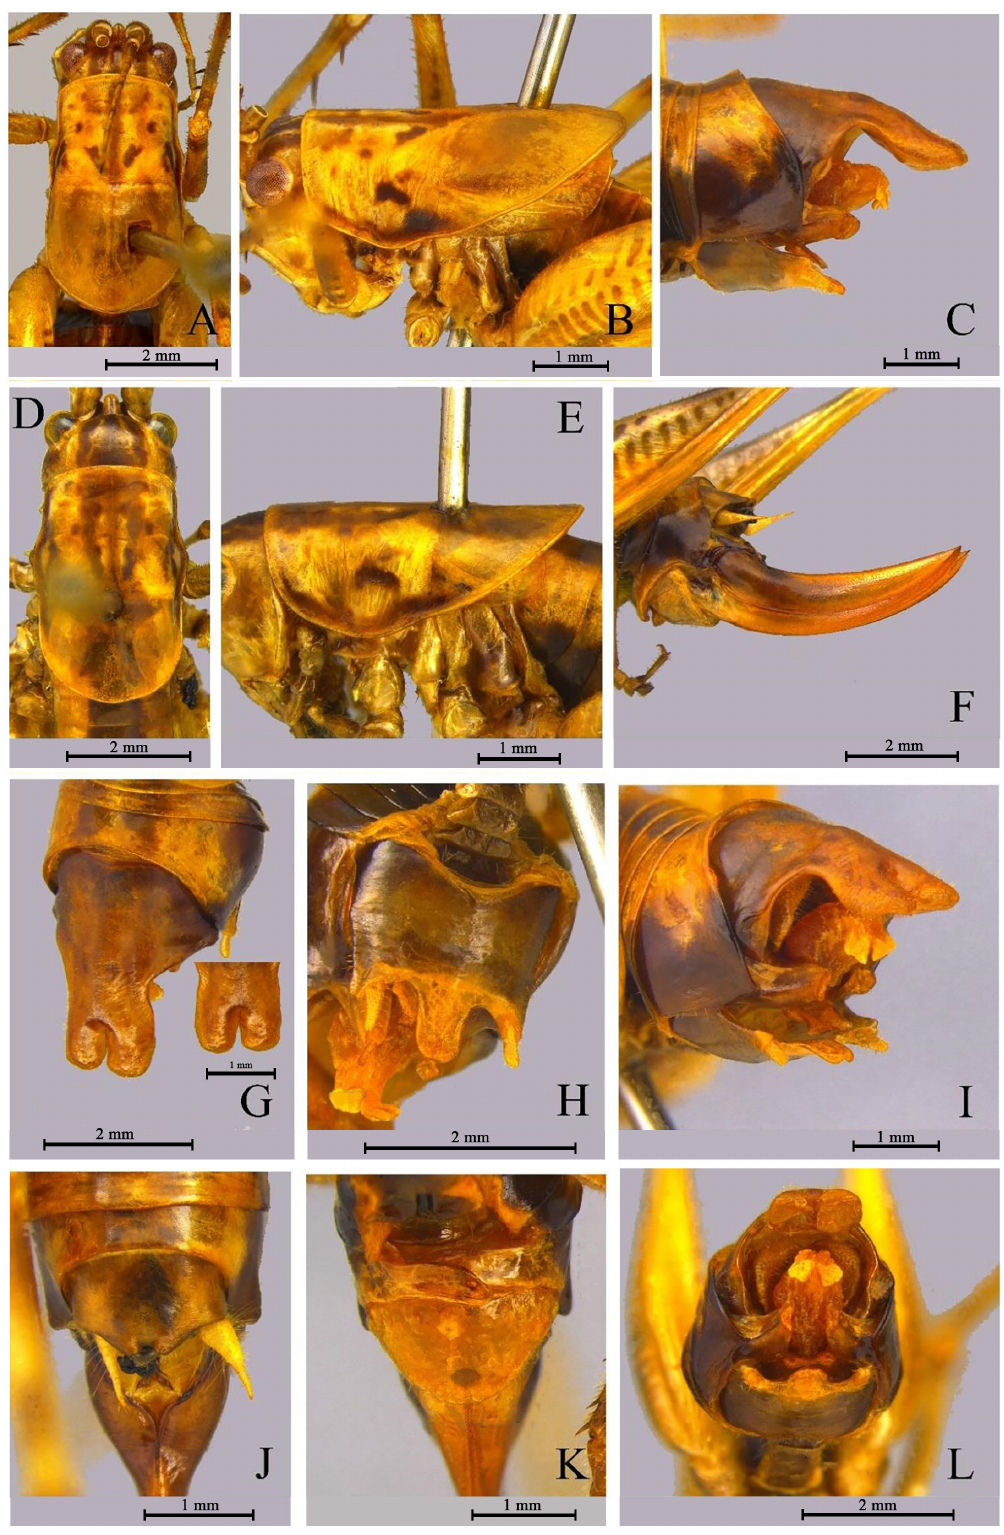
Fig. 5. Macrocosmetura truncata gen. et sp. nov. A–C, G–I, L . Holotype, ♂ (HBU). D–F, J–K . Paratype, ♀ (HBU). – A–B, D–E . Pronotum. A, D . Dorsal view. B, E . Lateral view. – C, F–L . Apex of abdomen. C, F . Lateral view. G, J . Dorsal view. H, K . Ventral view. I . Dorso-lateral view. L . Ventro-apical